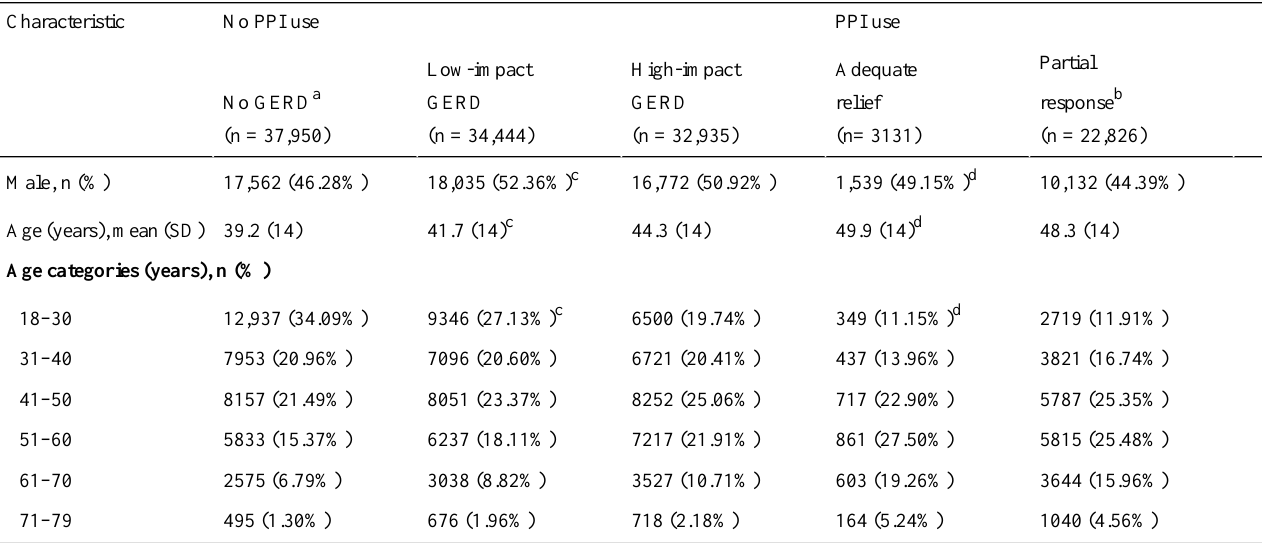
Table 1. Baseline characteristics of respondents with and without proton pump inhibitor (PPI) use.